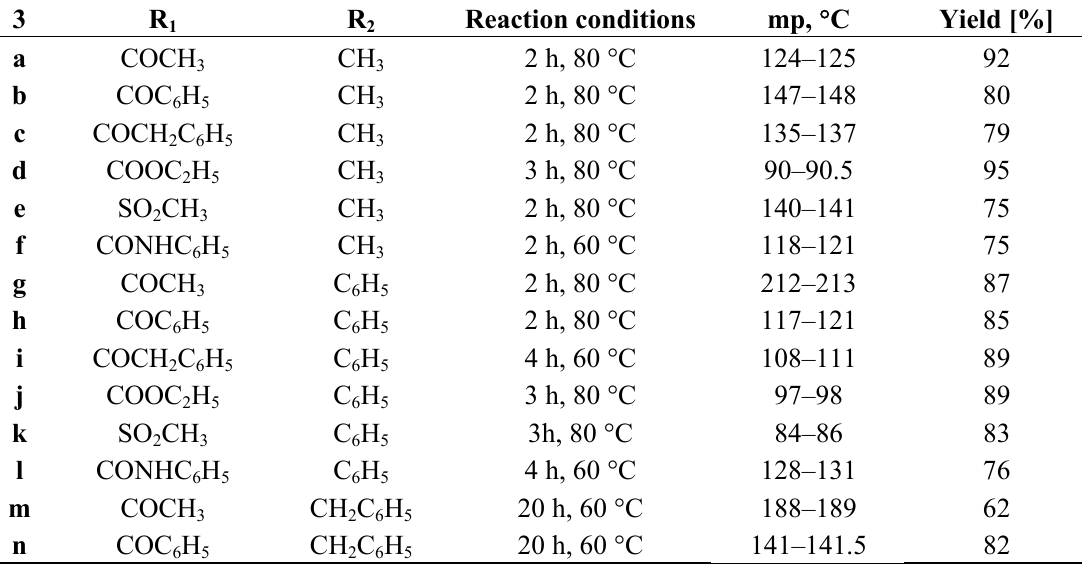
Table 1. Reaction conditions and yields for starting ketoamides 3